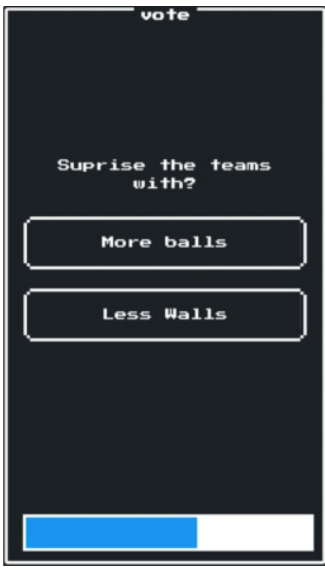
Figure 2. Voting page of the spectator’s interface with the timer bar below.